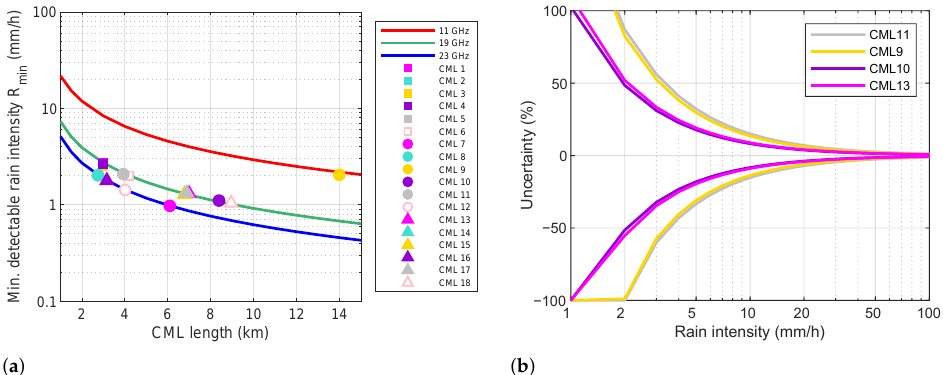
Figure 2. Sensitivity ( a ) and uncertainty ( b ) of rainfall intensity estimates due a 1 dB quantization error on CML raw data. The uncertainty plot in ( b ) shows the 95% confidence interval relative to the four CML used in this work to estimate rainfall